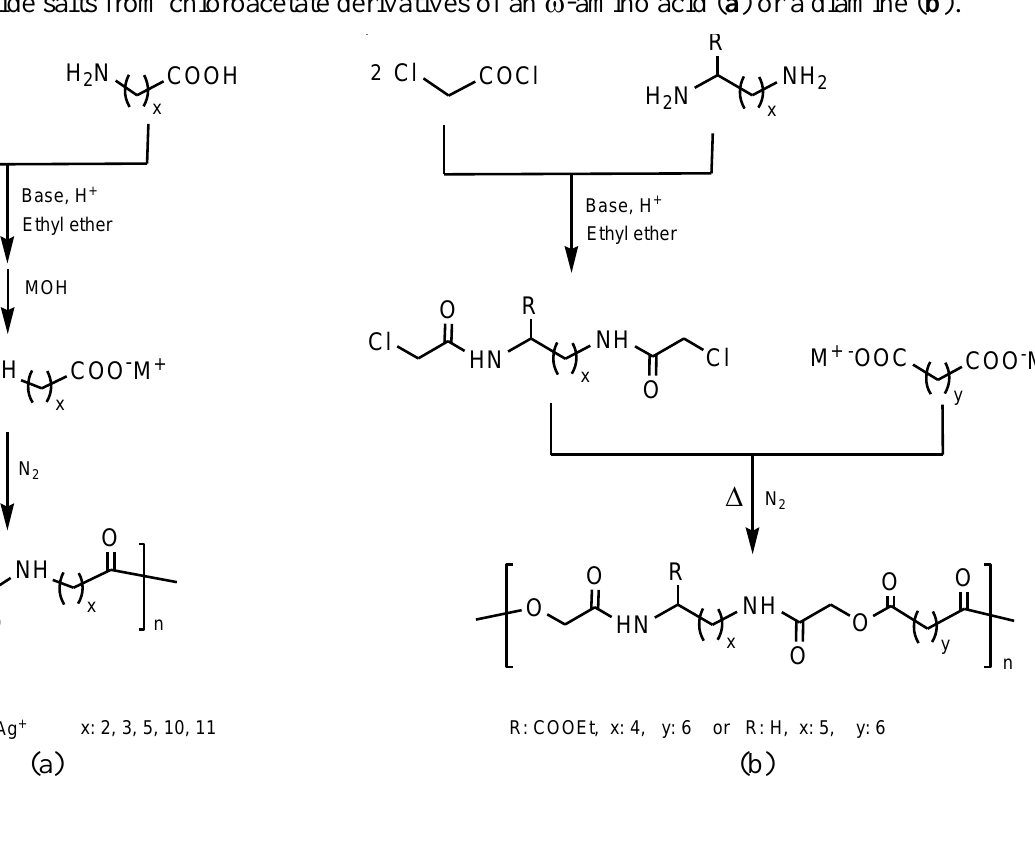
Figure 7. Synthesis of poly(ester amide)s by bulk polycondensation and formation